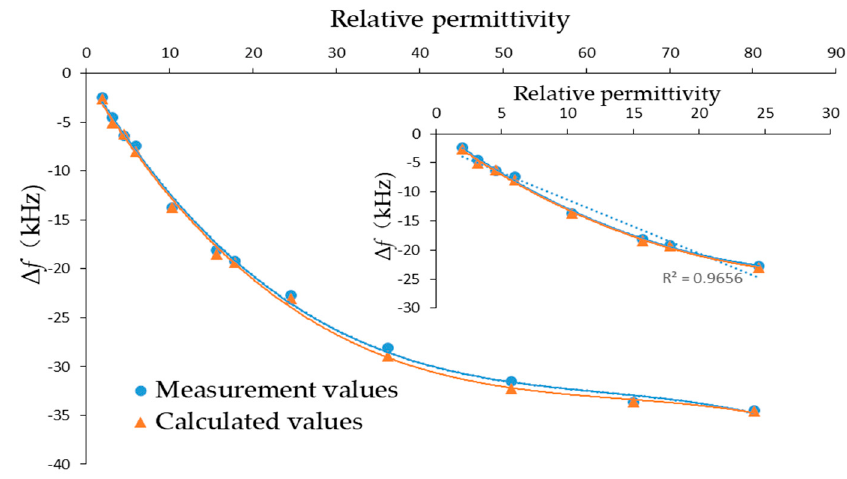
Figure 7. Measurement and calculated frequency shift caused by relative permittivity.